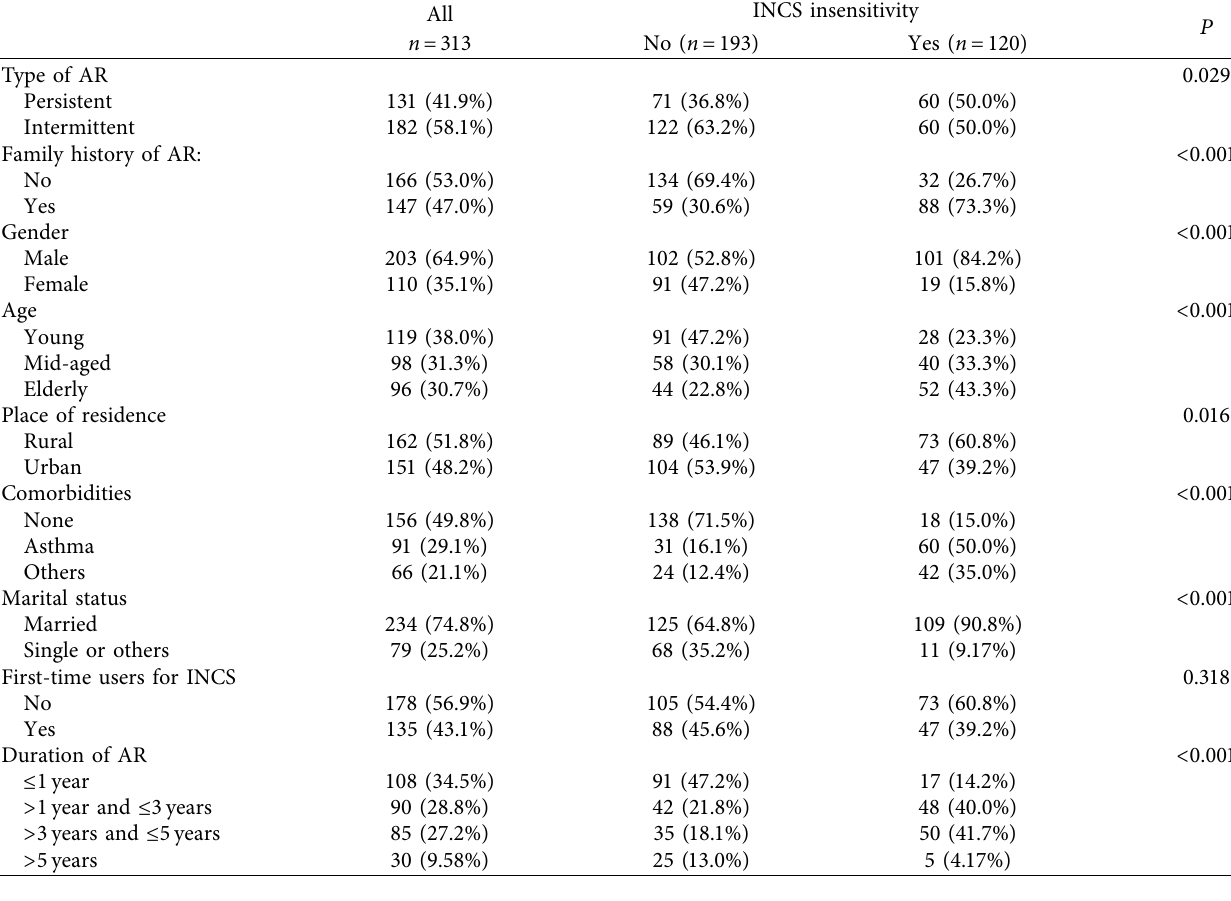
Table 1: Summary descriptive table by groups of “INCS insensitivity.”